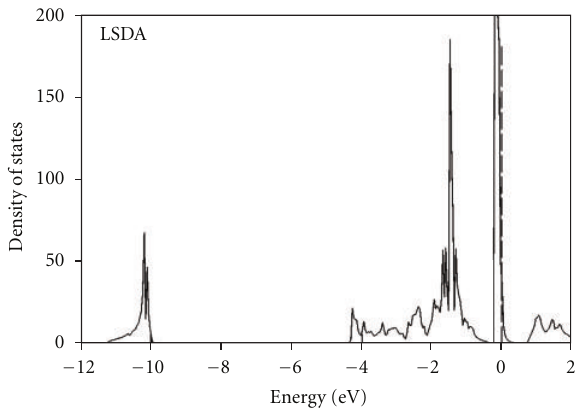
Figure 76: LSDA total DOS of Yb 4 As 3 [423] (in states per cell and